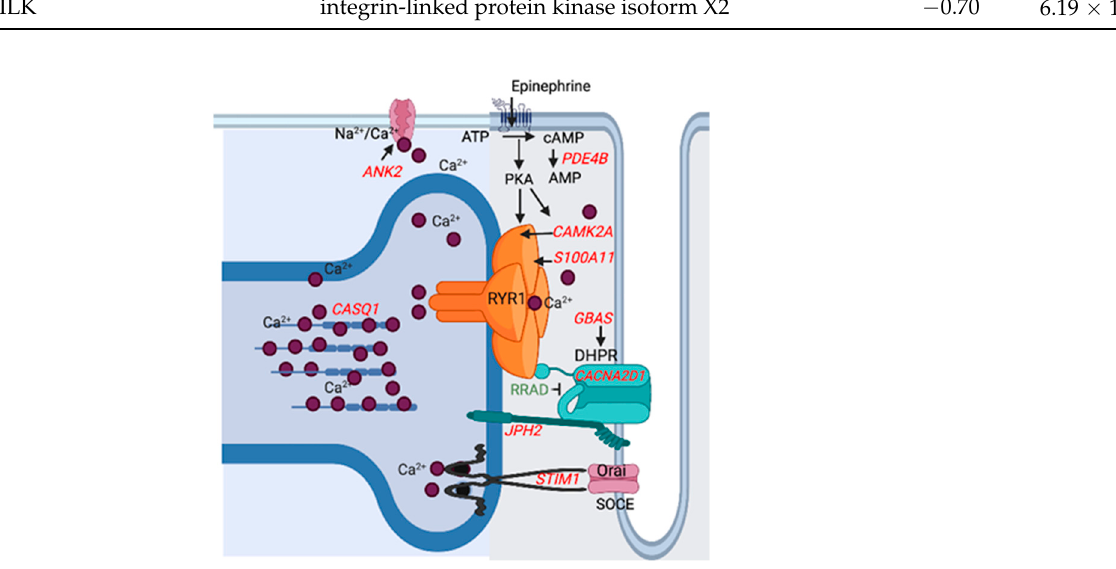
Figure 4. Depiction of the differentially expressed downregulated (red) and upregulated (green) genes that impact sarcoplasmic reticulum calcium stores ( CASQ1, STIM1 ) and myoplasmic stores ( ANK2 ) or modulate calcium release by the calcium release channel RYR1 . The dihydropyridine receptor ( CANA2D1 ) activates RYR1 resulting in sarcoplasmic reticulum calcium release. Down- regulated Protein NipSnap homolog 2 (GBAS) acts as a positive regulator and upregulated Ras related glycolysis inhibitor and calcium channel regulator (RRAD) an inhibitor of CANA2D1. Junctophilin-2 (JP2) inhibits RYR1 calcium release. S100 calcium binding protein A11 (S100A11) colocalizes with S100A1 which increases RYR1 calcium release. Calsequestrin-1 ( CASQ1 ) is a high-capacity, moderate affinity, calcium-binding protein that regulates the release of luminal calcium via RYR1. Calcium/calmodulin-dependent protein kinase type II subunit alpha (CAMK2) and protein kinase A (PKA) phosphorylate RYR1, which increases RYR1 calcium release. Beta adrenergic (epinephrine) stimulation activates protein kinase A (PKA) via an increase in adenylyl cyclase which is opposed by phosphodiesterase ( PDE4B ). Stromal interaction molecule 1 ( STIM1 ) is a calcium sensor that plays a role in mediating store-operated calcium entry (SOCE), enhancing calcium influx following depletion of sarcoplasmic reticulum stores. Ankyrin 2 (ANK2) is required for coordinate assembly of the Na 2+/ Ca 2+ exchanger.